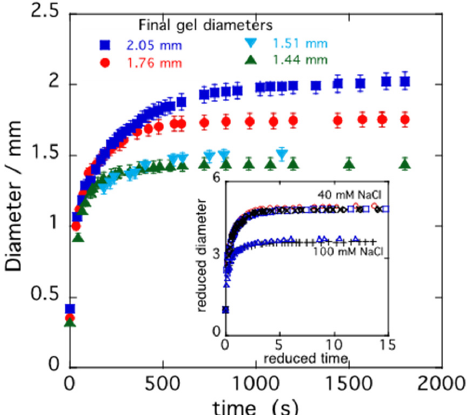
Figure 5. Swelling kinetics data of PA gels in 40 mM NaCl solution. Inset: reduced gel diameter d/d 0 vs. reduced time t/ τ 1 for PA gels swollen in 40 mM NaCl and 100 mM NaCl solutions. vs. reduced time t/ τ 1 for PA gels swollen in 40 mM NaCl and 100 mM NaCl